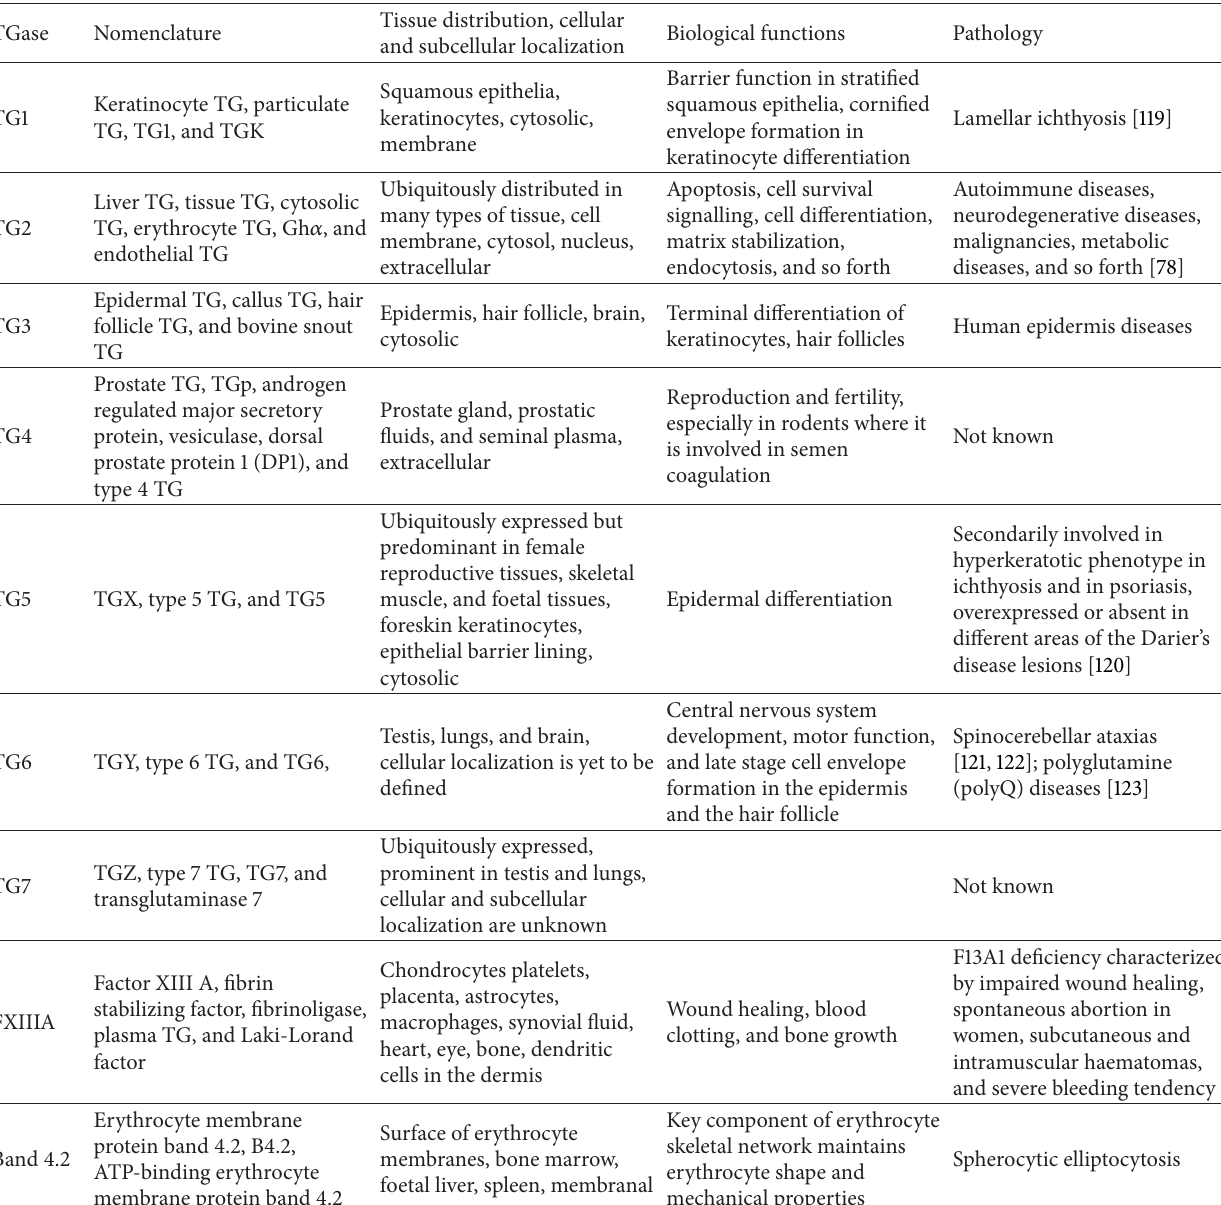
Table 1: Members of the transglutaminase (TGase) enzyme family, their nomenclature, tissue distribution, biological functions, and pathological involvement [4,